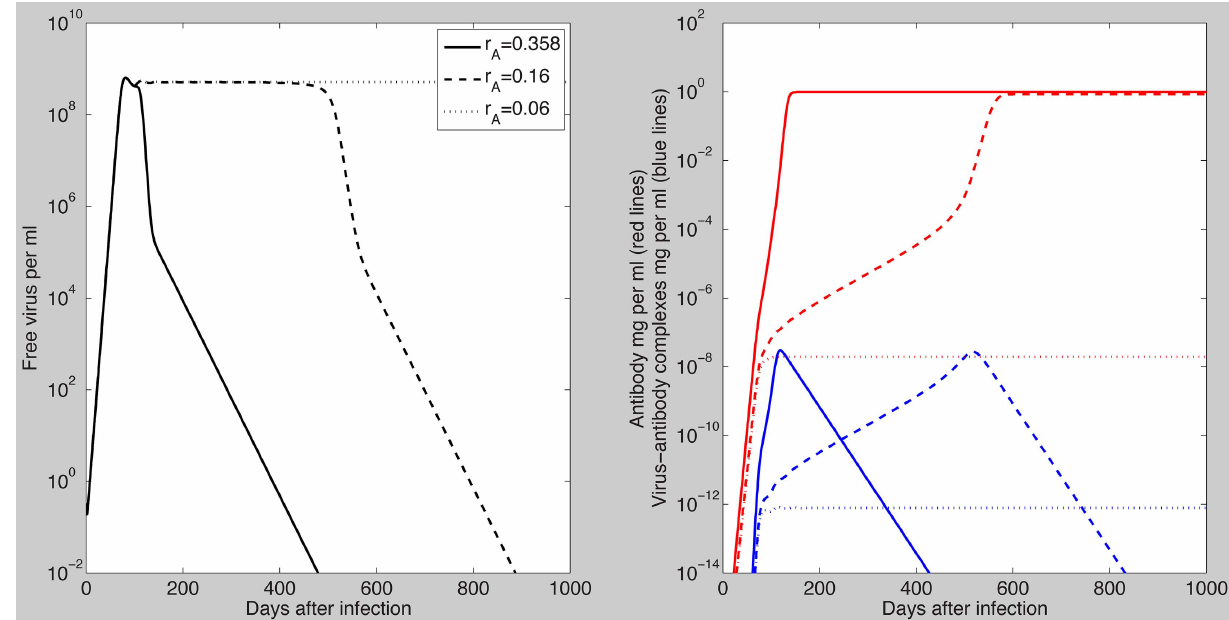
Figure 8. Free virus per ml (left panel); free antibody (red lines) and virus-antibody complexes (blue lines) in mg/ml (right panel) for r A ~ 0 : 358 d { 1 (solid lines); r A ~ 0 : 16 d { 1 (dashed lines) and r A ~ 0 : 06 d { 1 (dotted lines). The other parameters are as Tables 1 and 2 (median values).